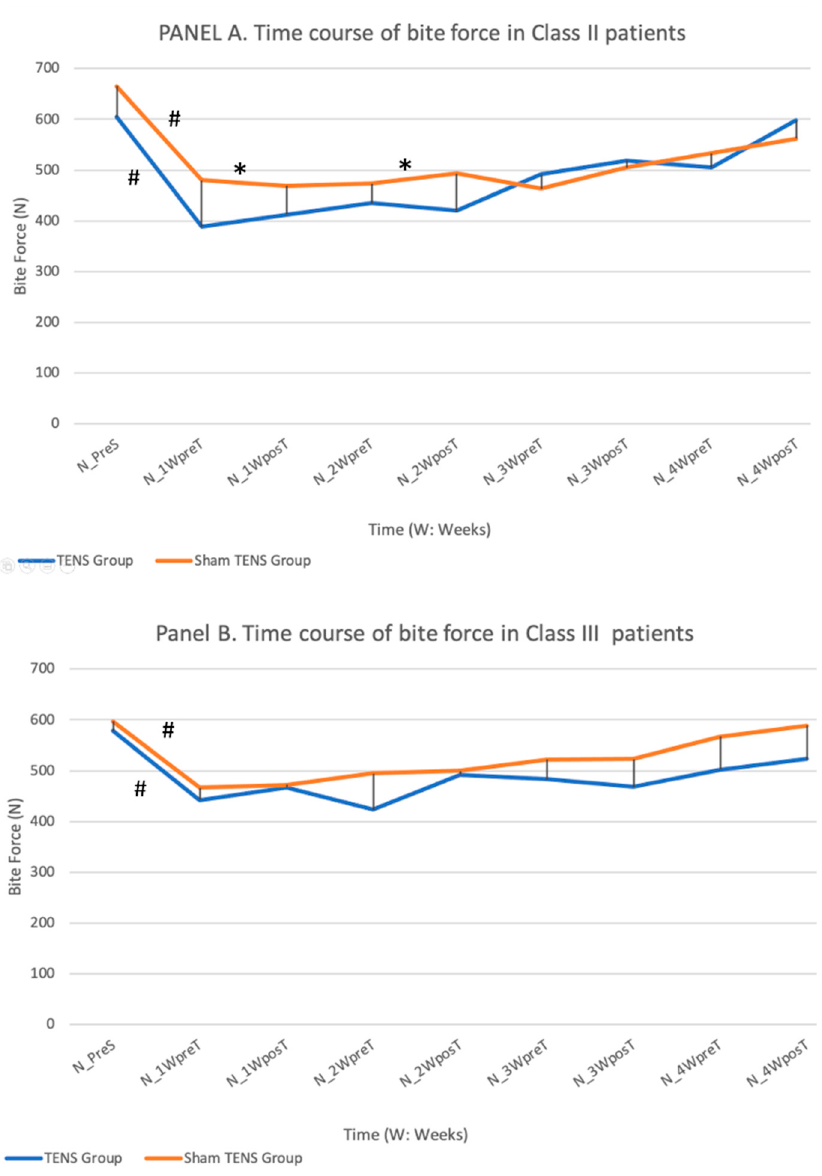
Figure 2. Depicts the changes in bite force after surgery in patients with skeletal class II ( A ) and III ( B ) receiving TENS and sham-TENS. ( # significant differences ( p < 0.05) between different time points in the same group, * significant differences ( p < 0.05) between groups).